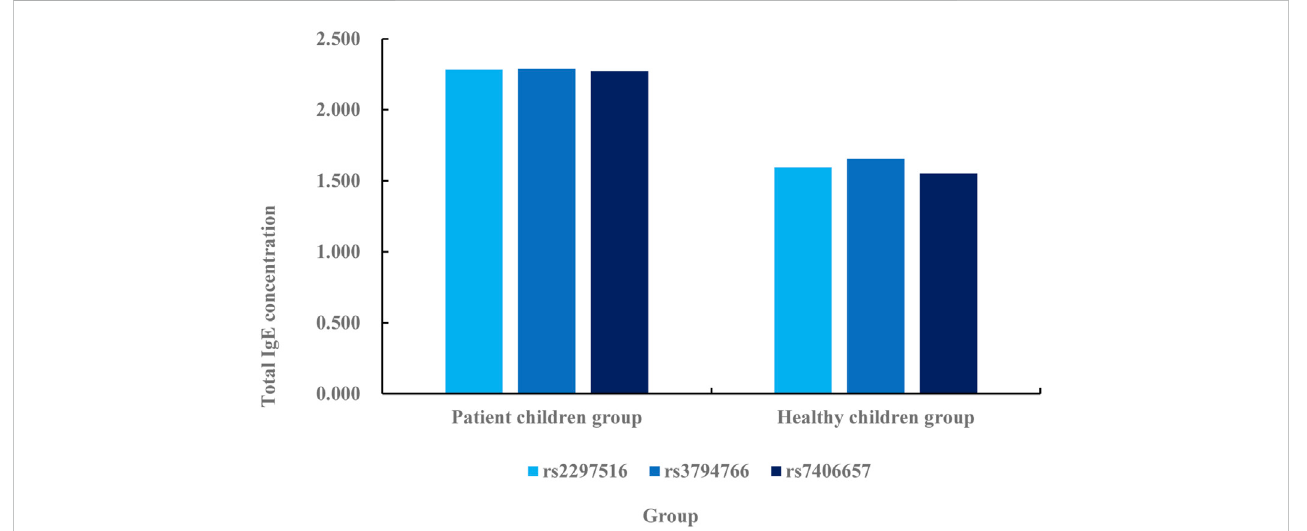
FIGURE 5 Correlation analysis between NOS2 gene SNP and total serum IgE concentration in patients and healthy children.